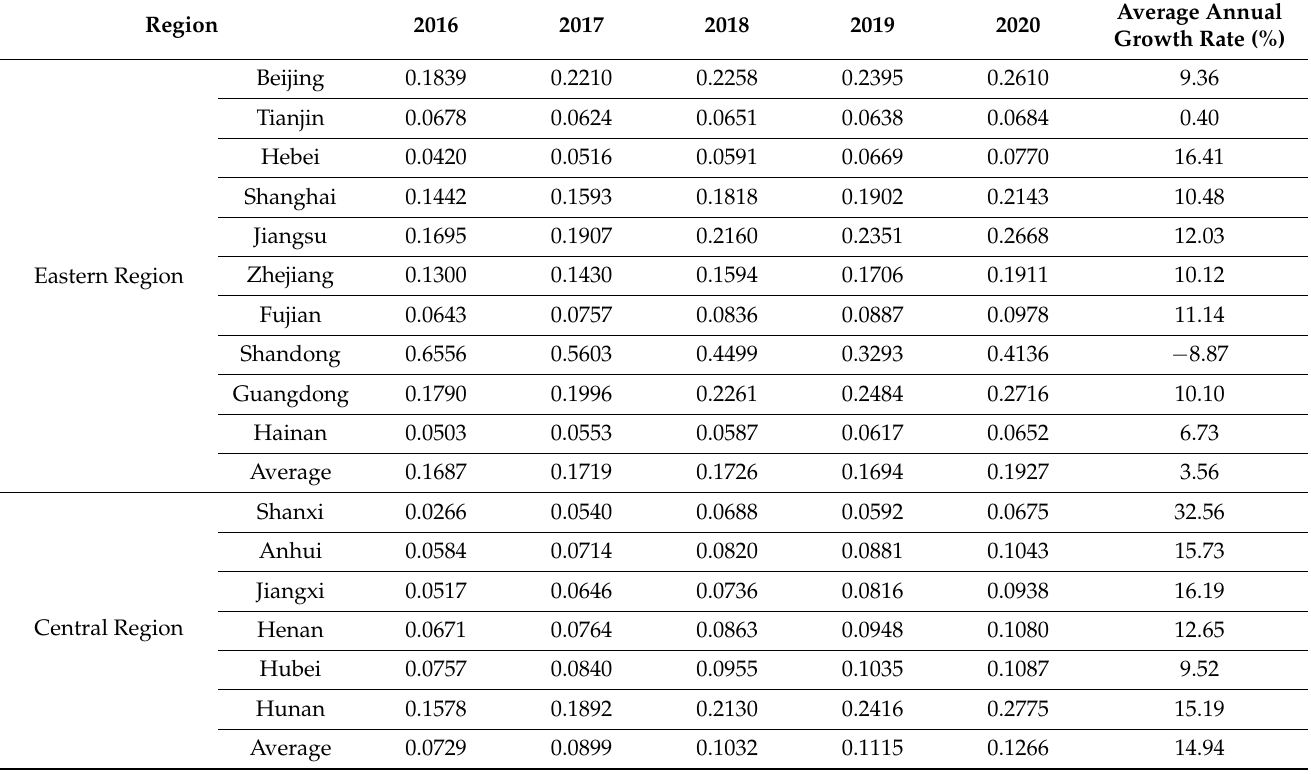
Table 4. Results of green and low-carbon transition efficiency measurement of